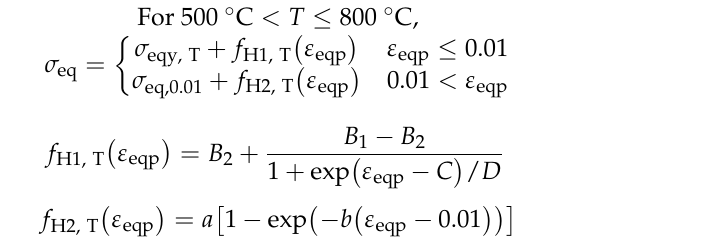
where σ eq,0.01 is the equivalent stress at ε eqp = 0.01 at T ◦ C; f H1, T and f H2, T represent the